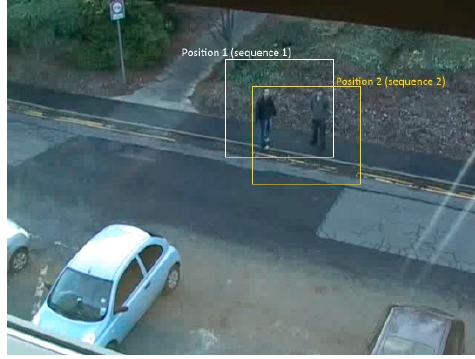
Figure 5. Example of augmentation ROIs.